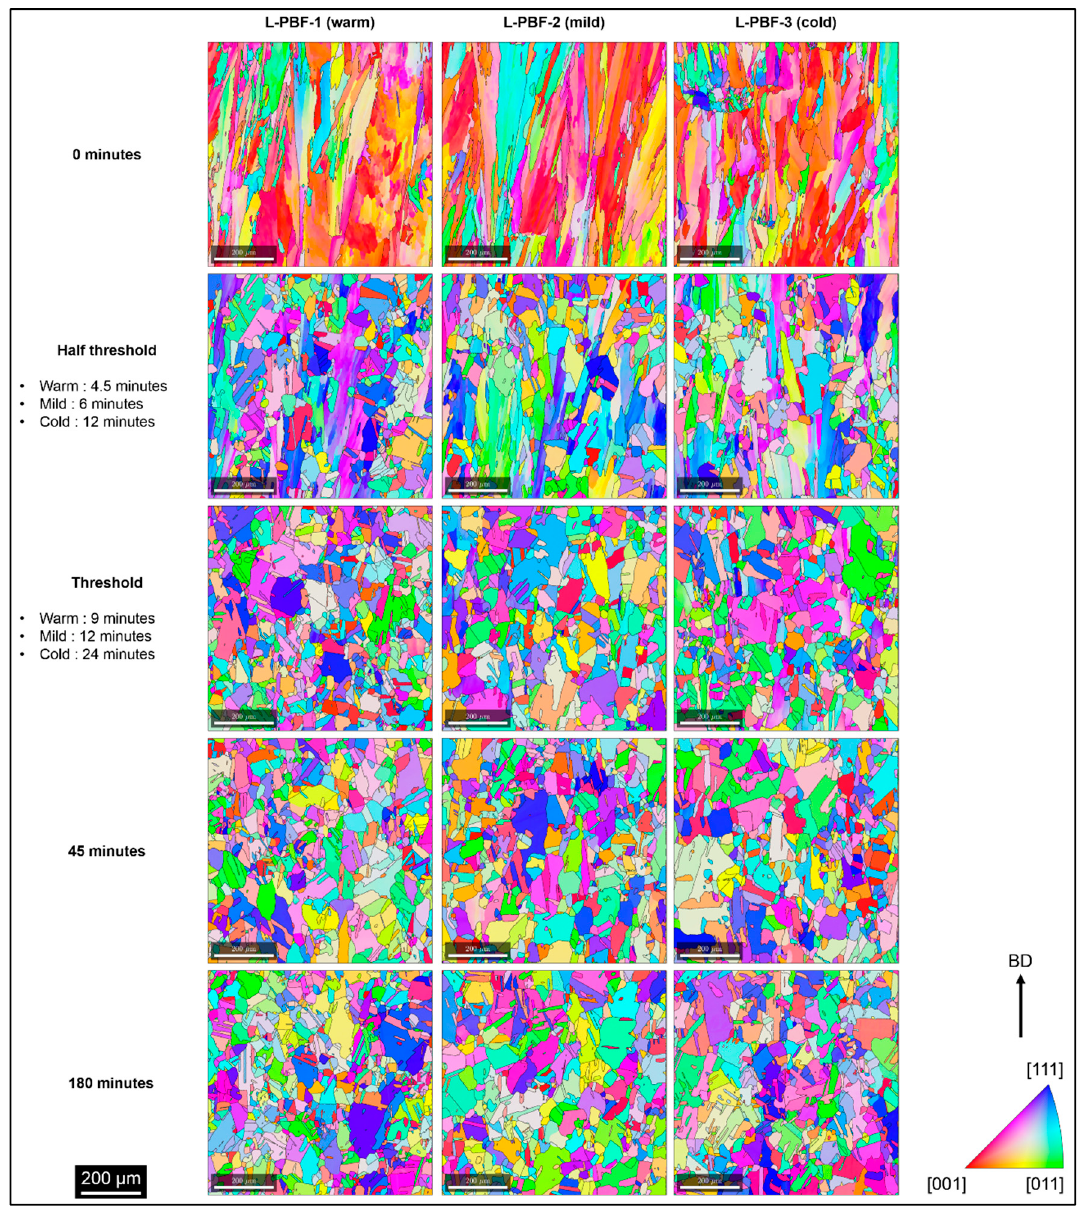
Figure 15. Influence of dwell time at 1100 ◦ C on the microstructures for the three L-PBF conditions (above the mentioned time thresholds t rec , recrystallization is